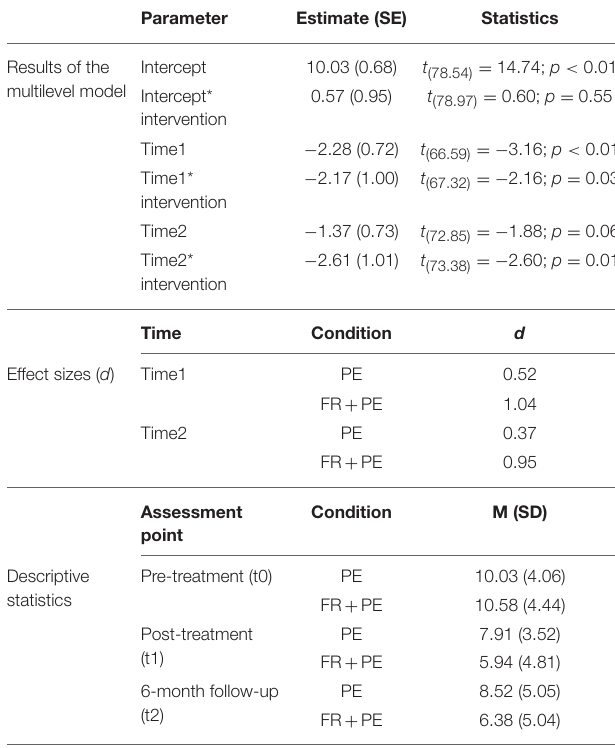
TABLE 3 | Results for the secondary outcome depression measured with the depression scale of the “Patient Health Questionnaire” (PHQ-9). Parameter Estimate (SE) Statistics Results of the multilevel model